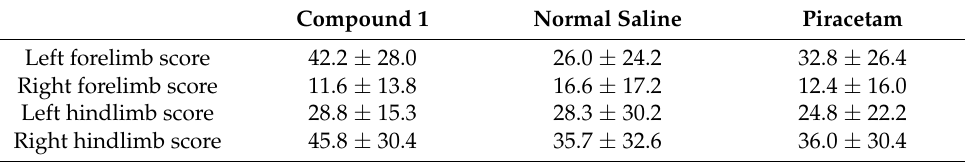
Table 4. Mean beam walking test scores on day 14 after